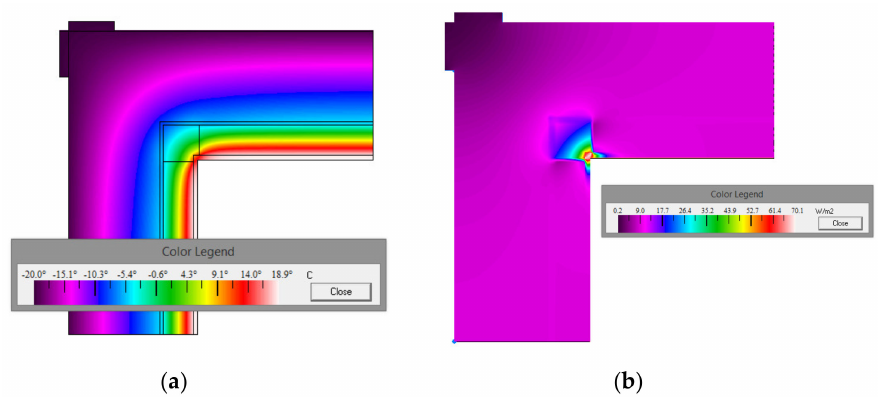
Figure 19. Comparison of calculation results for a wall corner with a thermal insulation layer 11 cm thick ( a —isotherm layout, b —heat stream density distribution).